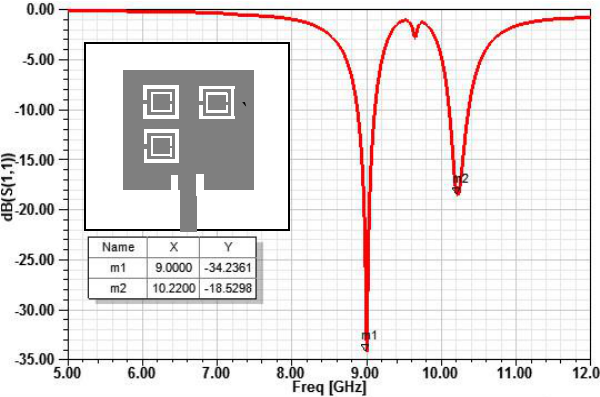
Figure 9: Fabricated antenna with four CSRR unit cells.